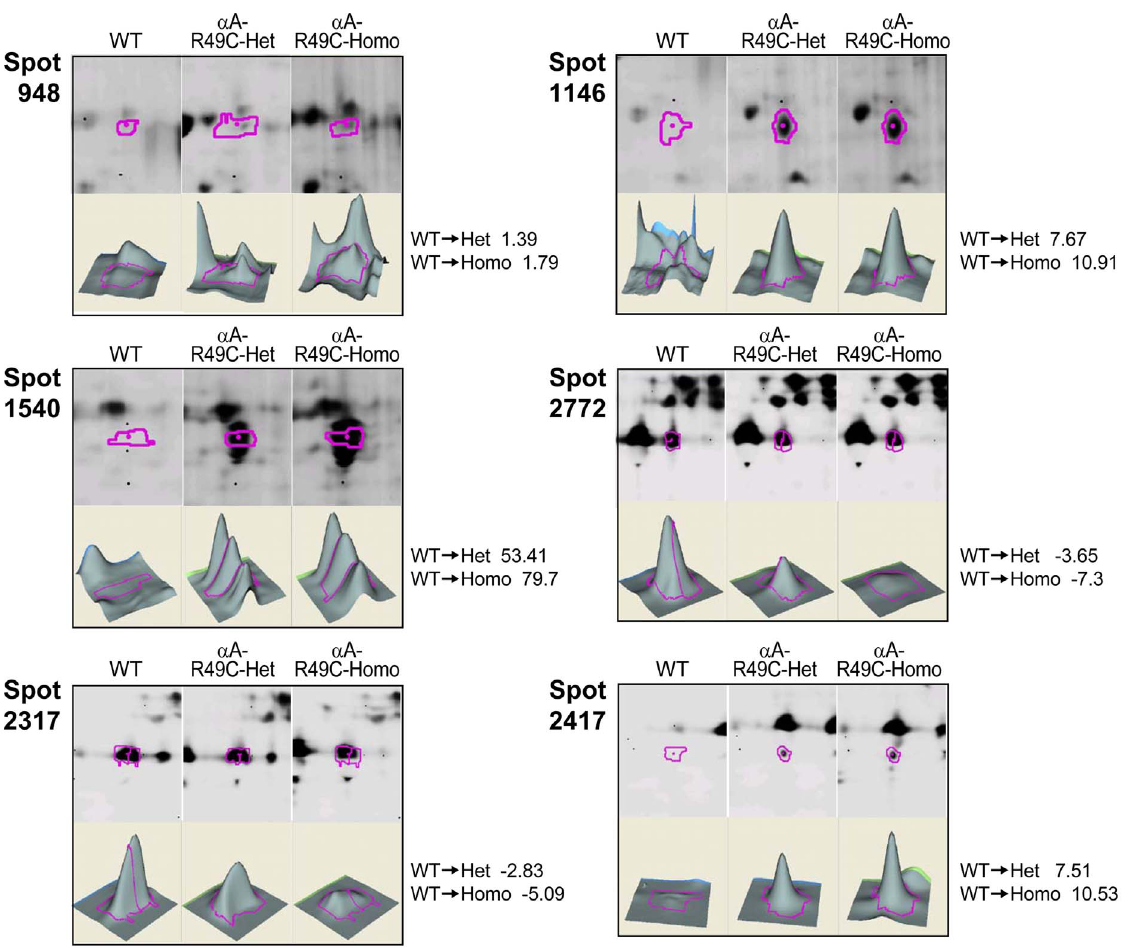
Figure 4. Pool-based quantitative analysis of changes in abundance of postnatal 2-day-old lens proteins from WT and a A-R49C knock-in lenses by mass spectrometry. The 3D data sets for representative proteins in one WT, one pool, and one a A-R49C heterozygous or a A- R49C homozygous mutant sample are shown. WT proteins were labeled with Cy2, pool proteins with Cy3, and a A-R49C heterozygous mutant proteins with Cy5. Fold changes between each sample are indicated on the right. See Table 2 for the identity of proteins present in each protein spot.